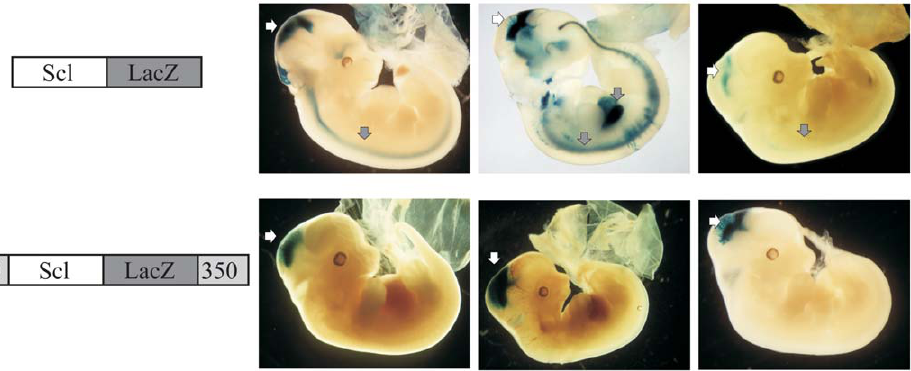
Figure 5. The 350 kb core region of the + 45 element improves tissue-specific expression of transgenes. The 350/Scl/LacZ/350 transgenic embryos consistently expressed LacZ in mid and hind brain (white arrow), reflecting endogenous expression pattern of Scl in brain, Scl/ LacZ transgenic embryos show ectopic expression (grey arrow). The transgenic constructs are depicted diagrammatically on the left panel, with photographs of 3 representative transgenic embryos presented on the right.